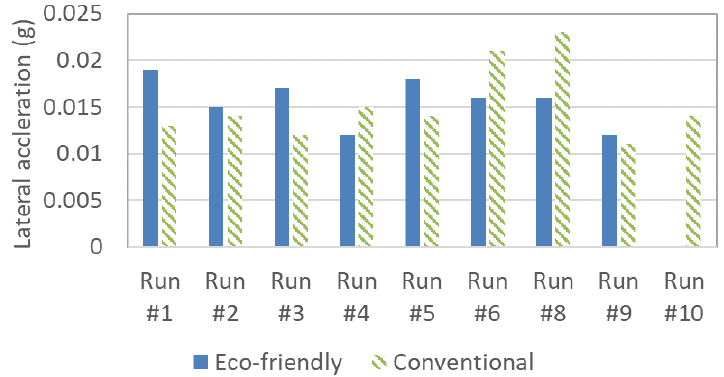
Figure 16. Vertical accelerations on the B2S panels.